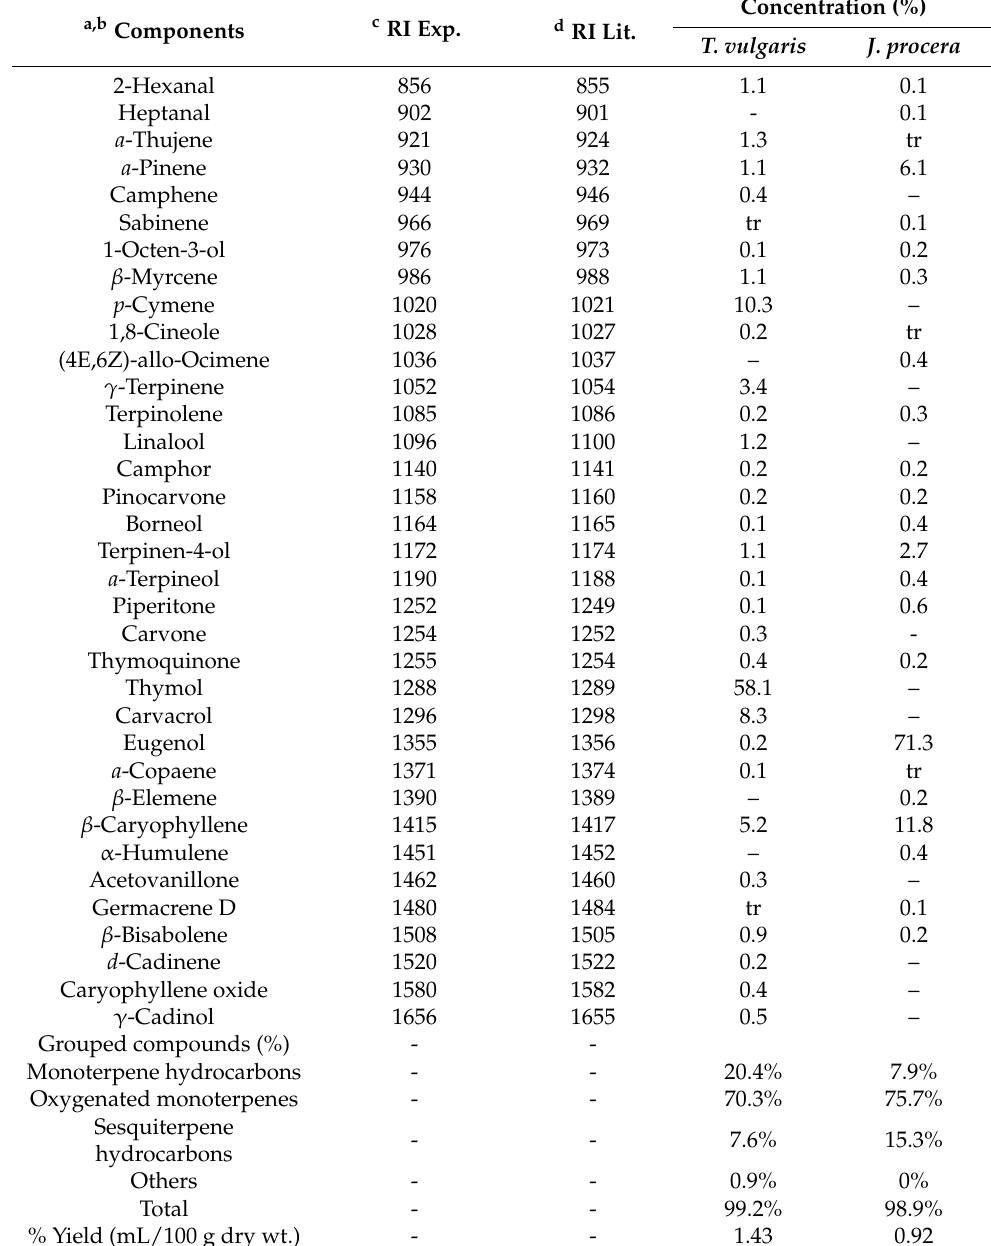
Table 1. Chemical composition of the plant oils under